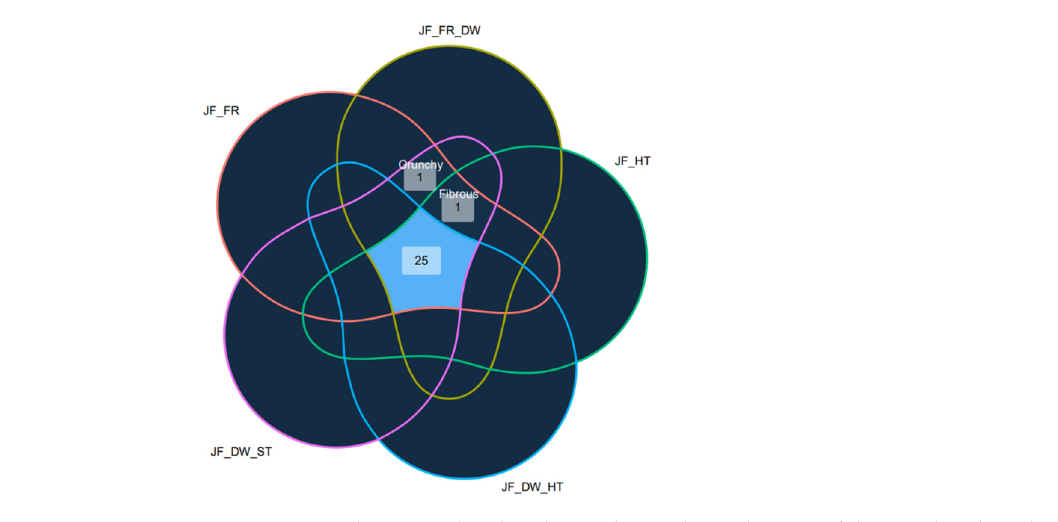
Figure 4. Error bar of the intensity mean score for descriptors selected for sample JF-FR-DW. Bars represent standard deviation. JF-HT (Figure 5) showed a standard deviation comparable to the other JF analyzed. The highest mean intensity was mainly scored on texture attributes (chewy, jelly-like, juicy) and sea-related attributes (sea odor, sea flavor and salty).